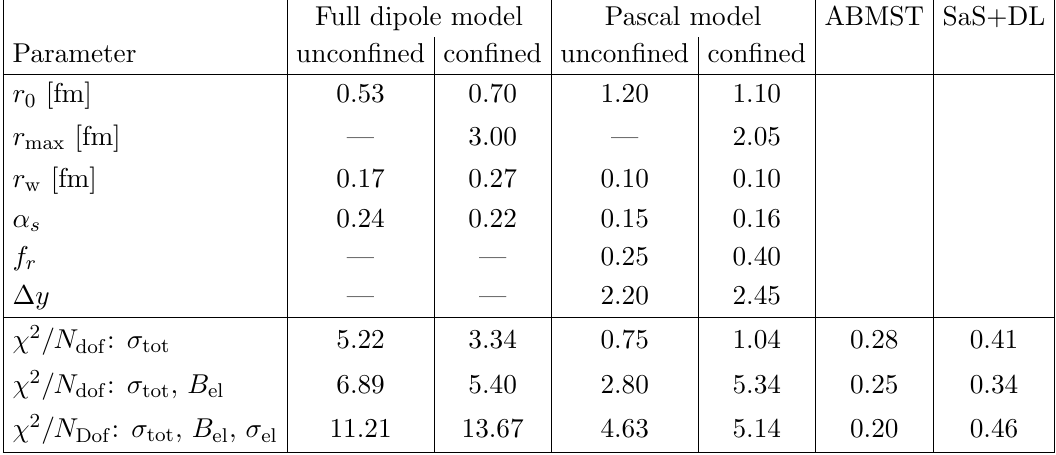
Table 4. The parameter values obtained when tuning to the (cid:27) obtained for the di(cid:11)erent